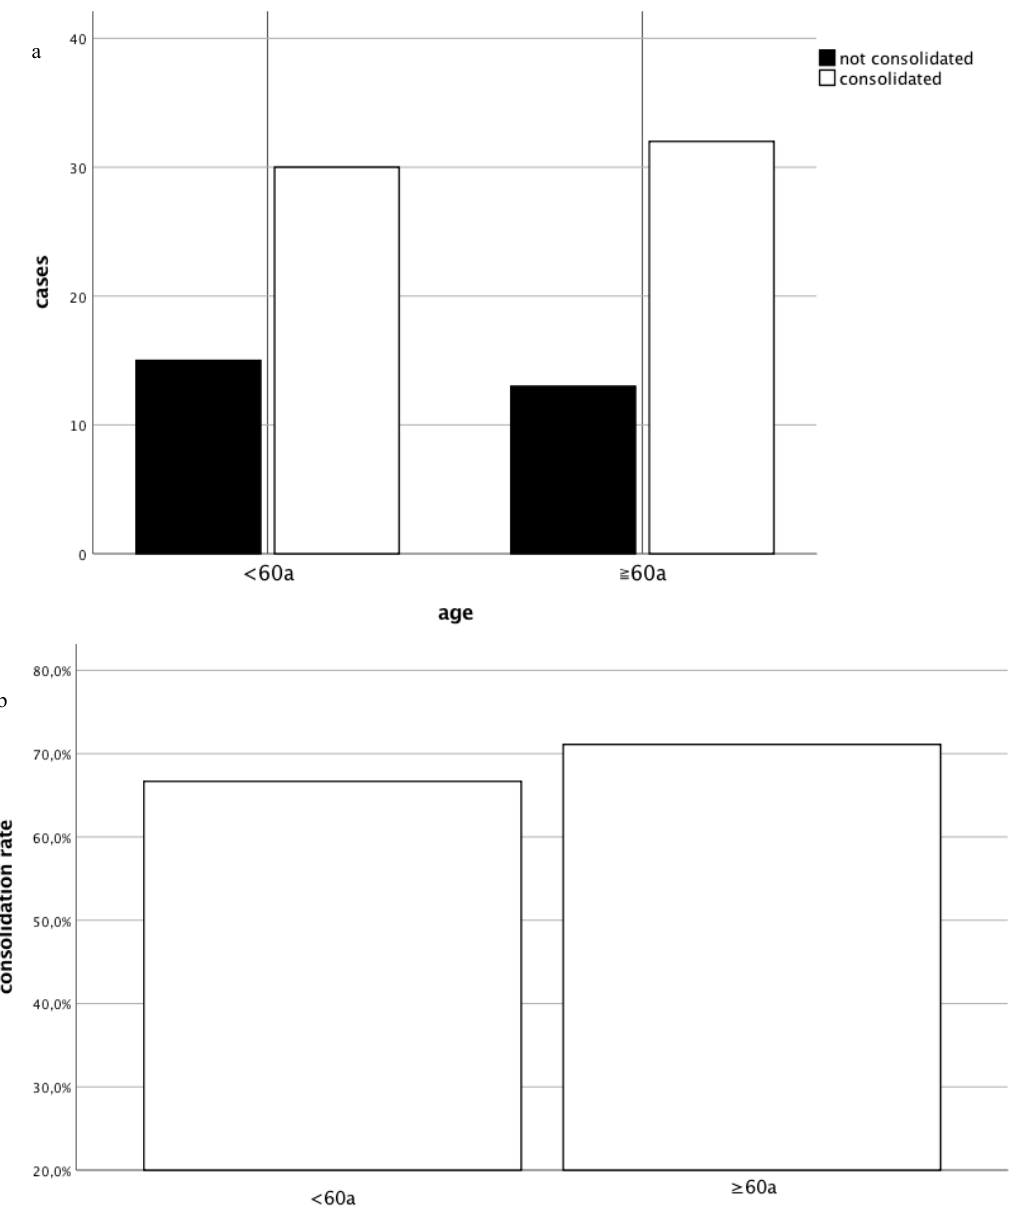
Figure 2. Radiological outcome of non-union treatment based on the “diamond concept”. The consolidation subsequent to the non-union therapy in respect to patients’ age is shown in absolute numbers ( a ) and percentage ( b ).